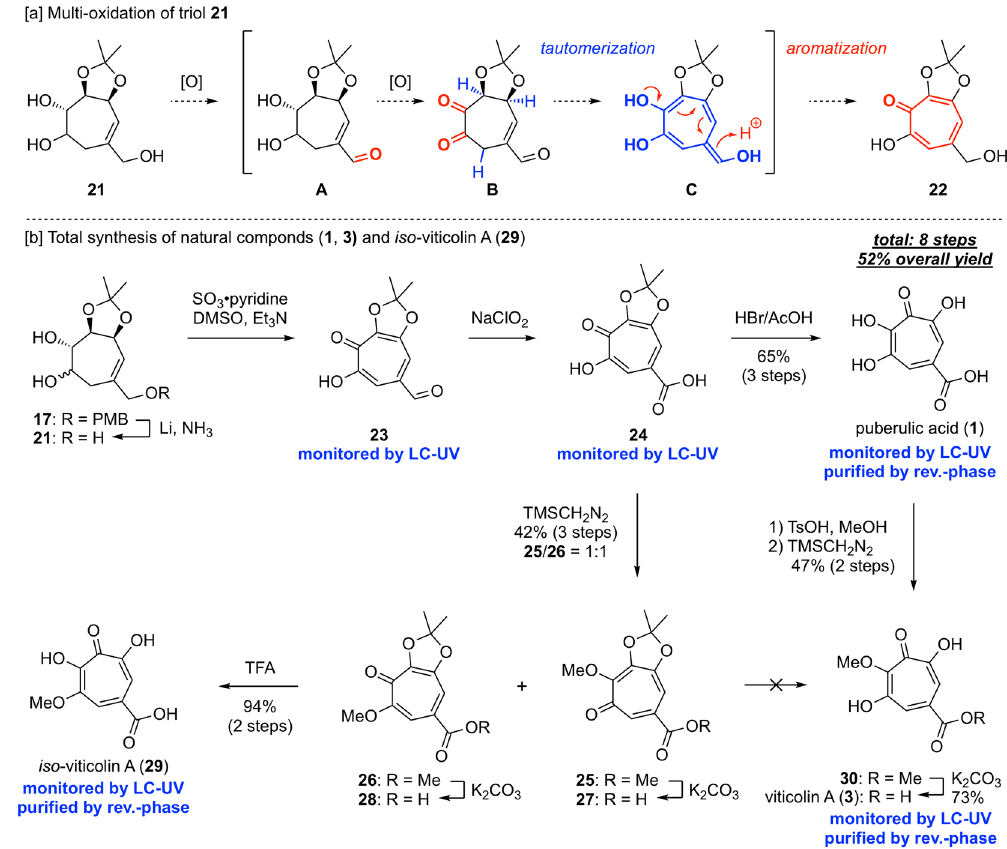
Figure 4. Aromatization strategy and total synthesis of natural